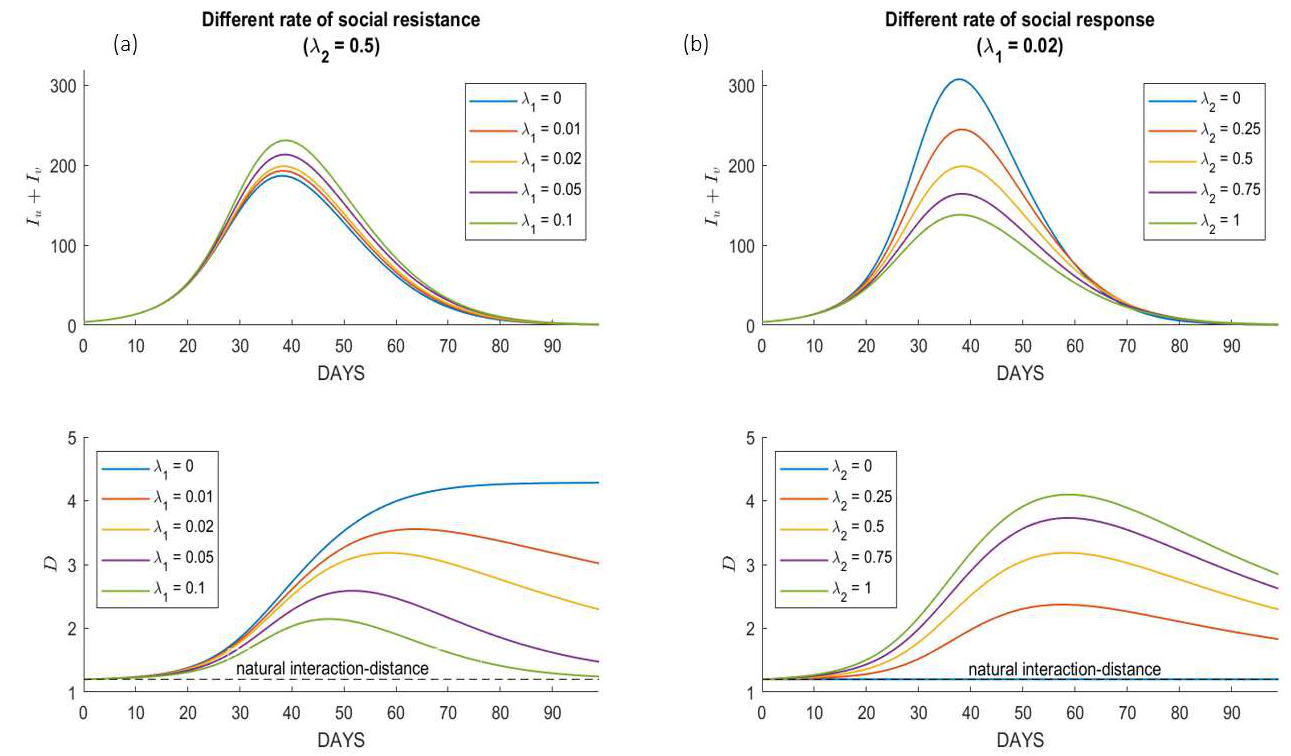
Figure A1. Number of infected individuals in society of population 1000 individuals under different values of socio-resistance and social response rates. ( a ) five different values of socio-resistance by setting λ 2 = 0.5. Each scenario has R 0 = , for ascending order of λ 1 . ( b ) Five different values of social response by setting λ 1 =